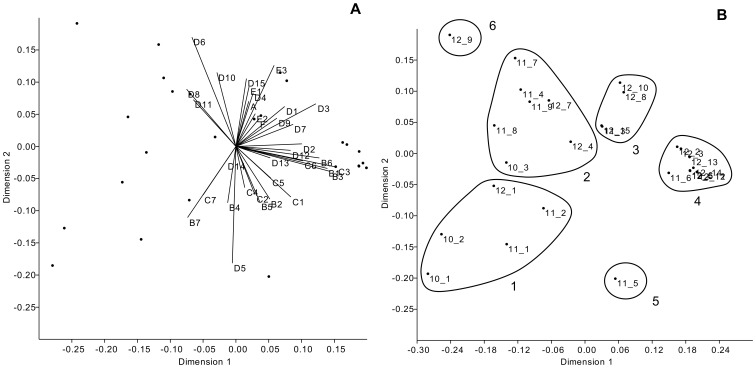
Plots of the Italian 2010–2012 H5N2 LPAI outbreaks in the first two NMDS dimensions.Plot A shows each environmental variable’s axis of differentiation, aligned in the ordination space, over the scaled spatio-temporal and flock type-related characteristics of the outbreaks. Plot B shows the final configuration of the outbreaks in the first two NMDS dimensions charted according to cluster assignment. See Tables 1 and 2 for details about the outbreaks and the environmental variables.